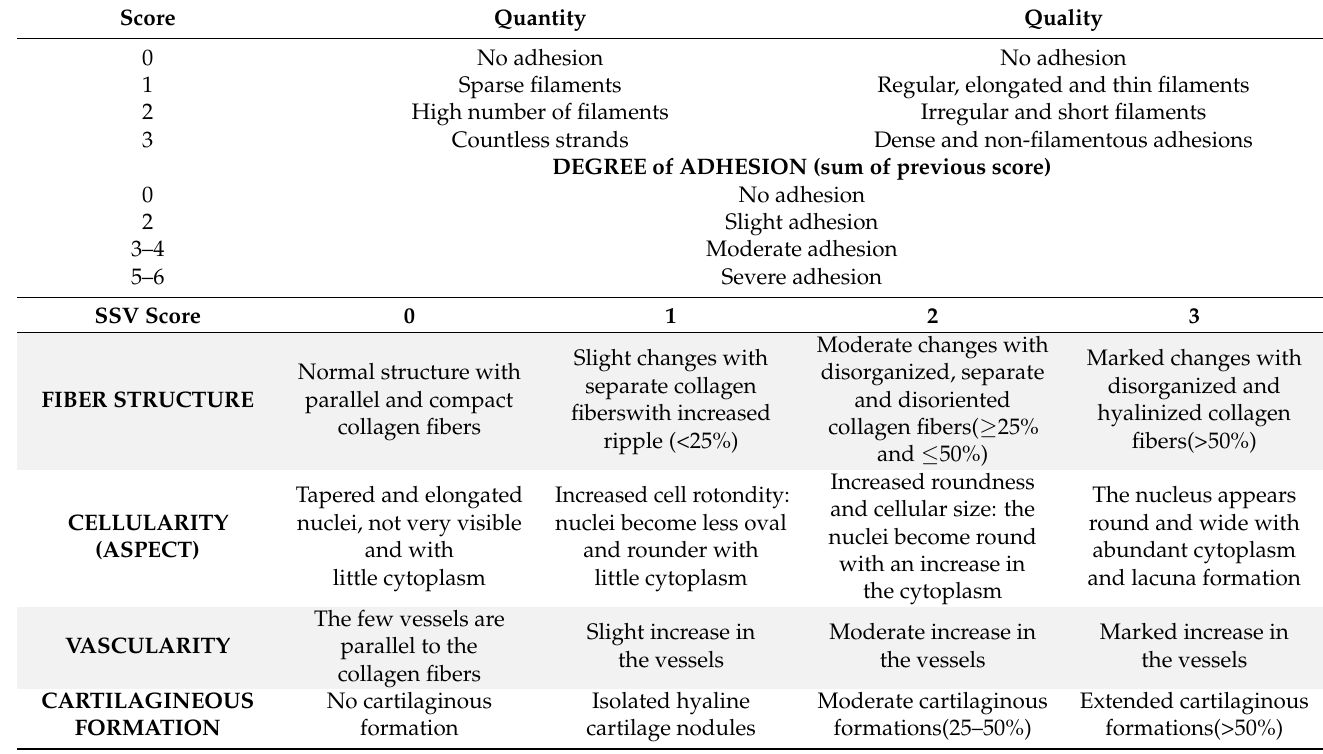
Table 1. The Tang score, used to evaluate adhesion of tendons, and Soslowsky, Svesson, and Cook (SSV) score, used to evaluate tendon